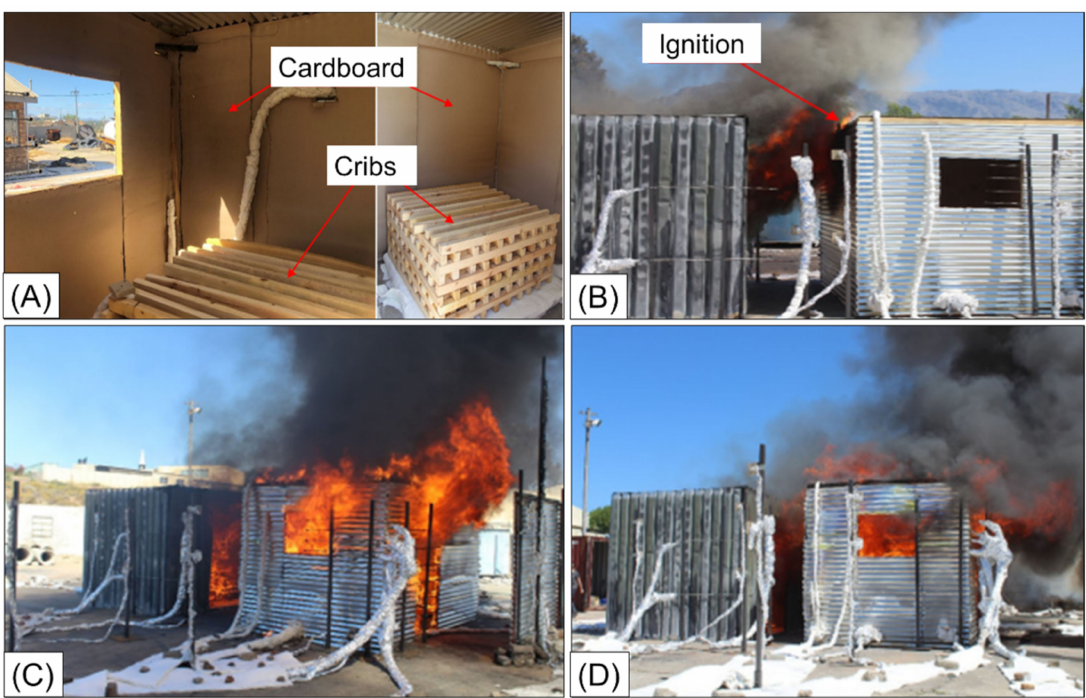
Figure 1. The effect of separation distance between informal dwellings on fire spread rates ( A ) Interior and wood crib arrangement; ( B ) ignition from ISD1 to ISD2; ( C , D ) fire spread between dwellings at 1 m and 1.75 m